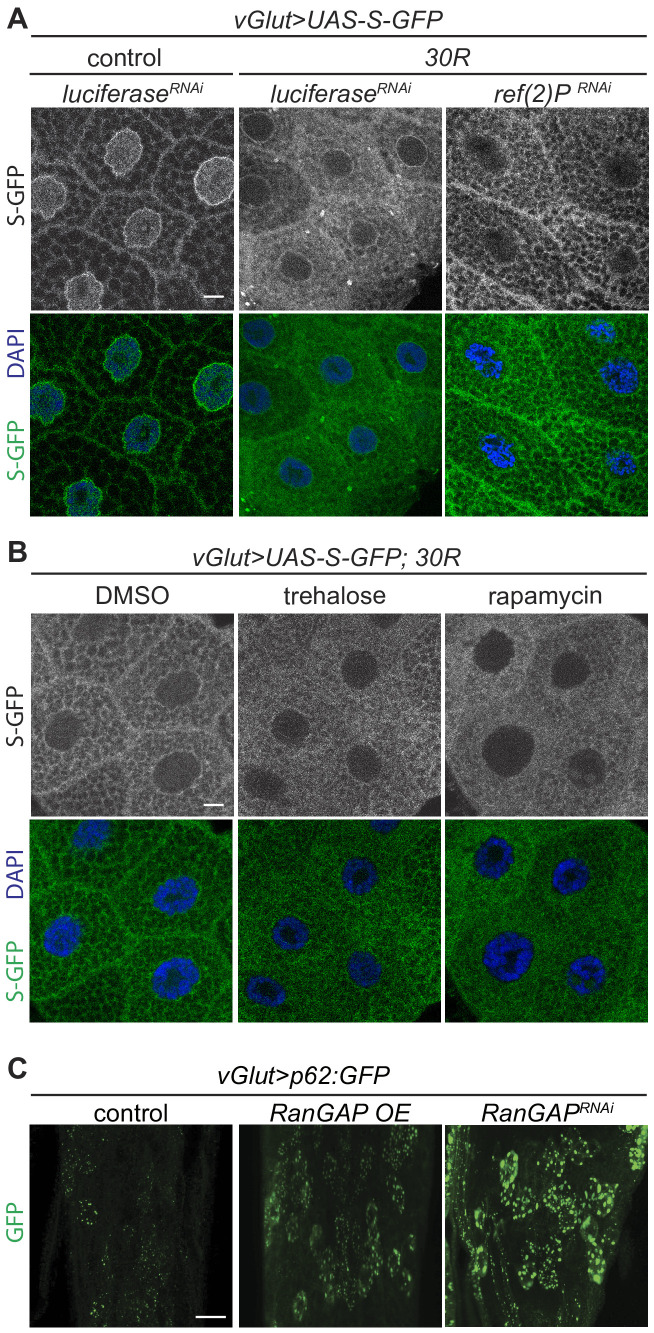
Nucleocytoplasmic transport disruption is upstream of autophagic defects.(A) Images of the nucleocytoplasmic transport marker shuttle-GFP (S-GFP) in control and vGlut > 30R with either UAS-luciferase (control) or UAS-Ref(2)P RNAi #1 expressed in Drosophila salivary glands. (B) Images of L3 salivary gland expressing UAS-S-GFP in vGlut > 30R Drosophila after feeding supplemented with control (DMSO), 0.2% trehalose, or 1.0 µm rapamycin. (C) Representative images of ventral nerve cords expressing control, knockdown of RanGAP (UAS-RanGAPRNAi), or overexpression of RanGAP (UAS-RanGAP), along with UAS-p62:GFP in vGlut motor neurons. Scale bars = 10 µm.